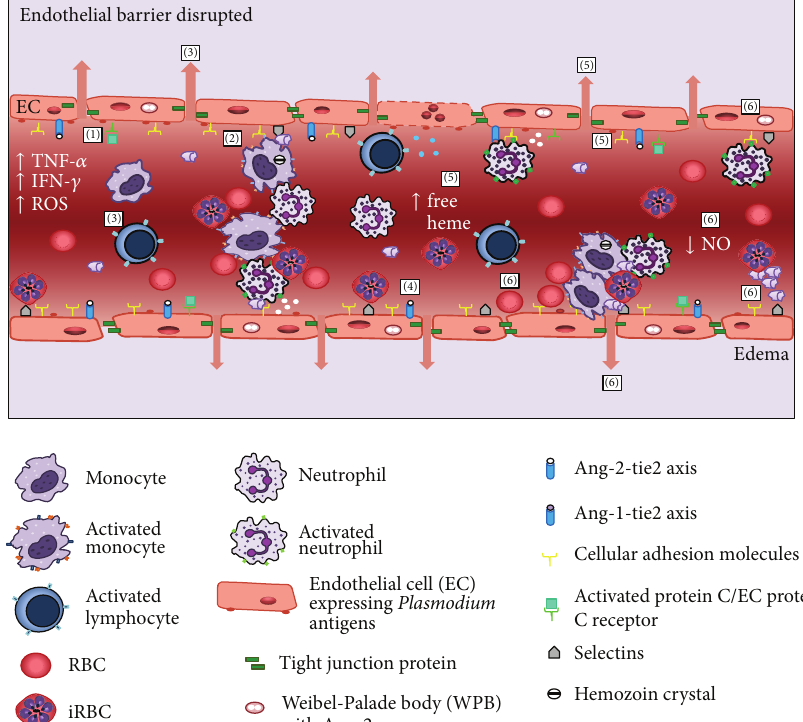
Figure 2: Targets of adjuvant therapies during malaria. Scheme showing several approaches that have been investigated aiming at modulation of malaria-induced inflammatory response. EC: endothelial cell; ROS: reactive oxygen species; SMC: smooth muscle cell. (1) Activated protein C binds to protein C receptor in activated EC cells decreasing the expression of adhesion molecules. (2) Statins decrease the production of chemokine and diminished the adhesion of leukocytes to brain microvasculature. (3) Sphingosine-1-phosphate (S1P) decreases the numbers of lymphocytes in brain vasculature and stabilizes the tight junction protein ZO-1 in brains. (4) Neuregulin-1 and bone marrow mesenchymal stromal cells induce Ang-1, which promotes stabilization of EC tight junctions, EC desensitization to TNF- 𝛼 , and downregulation of ICAM- decreases production of proinflammatory cytokines, impairs EC activation, and inhibits the expression of 1 and VCAM-1. (5) Lipoxin A 4 cellular adhesion molecules involved in leukocyte adhesion by stimulating the activity of HO-1, which catabolizes free heme. (6) L-Arginine or inhaled NO (iNO) reduces pulmonary edema and, in addition, decreases cytoadherence of iRBC, hemorrhagic foci, and leukocyte and platelets adherence to brain vasculature by inhibiting of WPB exocytosis that impairs the release of Ang-2 and inhibiting TNF- 𝛼 production and procoagulant activity of endothelial